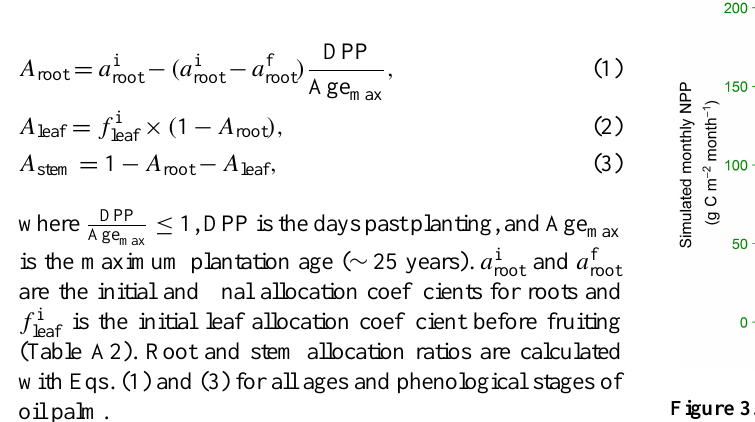
Figure 3. Time course of reproductive allocation rate (blue line) in relation to monthly NPP from the previous month (NPP month , green line) according to Eq. (5). A fruit is relative to the vegetative unity ( A leaf + A stem + A root = 1 and 0 ≤ A fruit ≤ 2 ) . The data shown here were simulated with calibrated parameters for the PTPN-VI